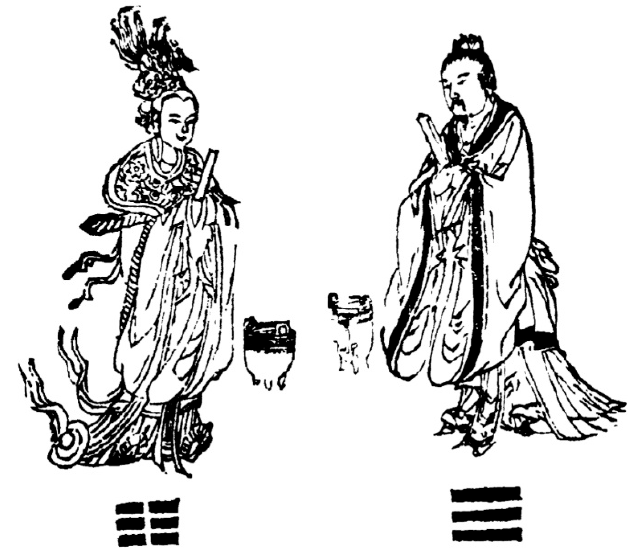
Figure 8. The diagram of the tripods found in the Daoist Canon version.